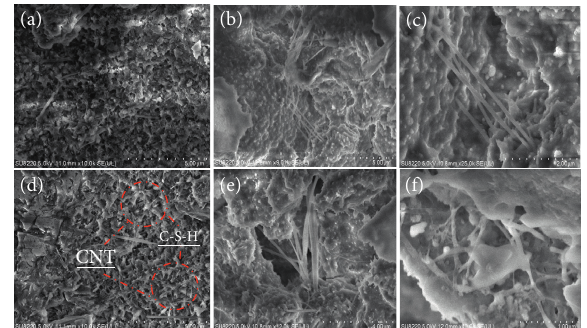
Figure 9: The SEM images of CNT-mortar samples with the various dosage of CNT-COOH after 28 days of curing time: (a–c) C5; (d–f)